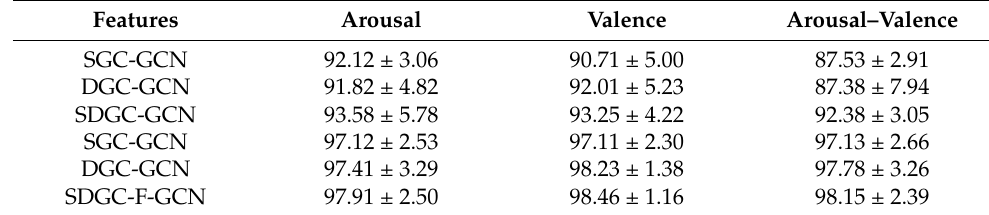
Table 3. Emotion recognition performance of GC-GCN graph features with different threshold k .